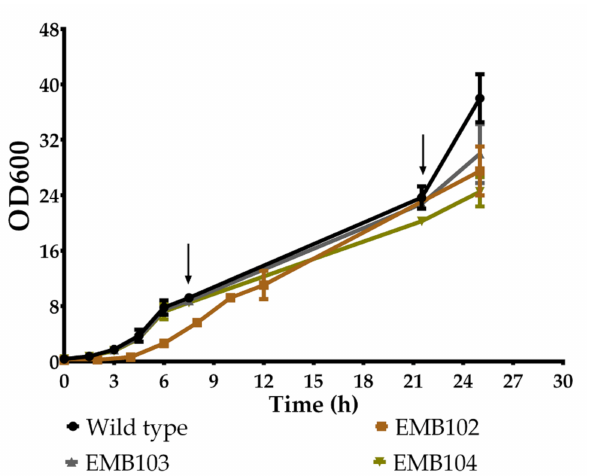
Figure 3. Growth profile of EMB102, EMB103, and EMB104 and O. polymorpha NCYC495 yku80 strain. The experiment was performed in YPD, using shake flasks. The arrows indicate the approximate times of supplementation with methanol to a final concentration of 1%. Means and standard deviations were calculated from two biological